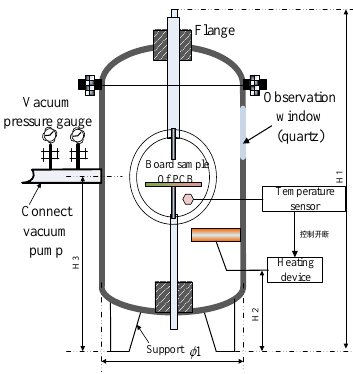
Figure 6. Model map of the device.